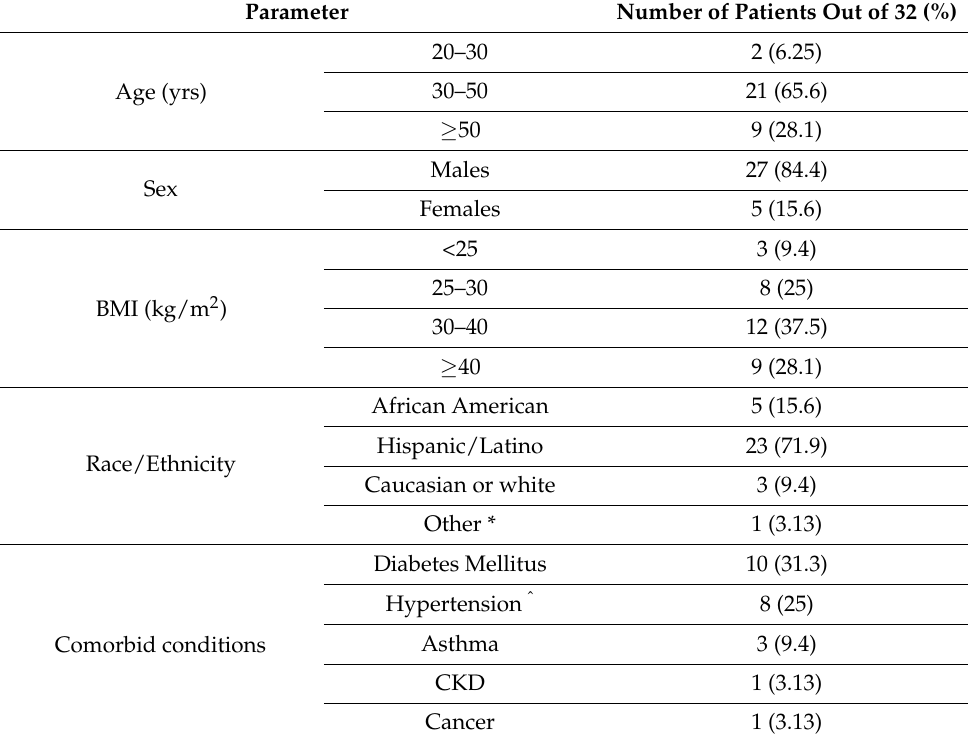
Table 1. Characteristics of the subjects (N =